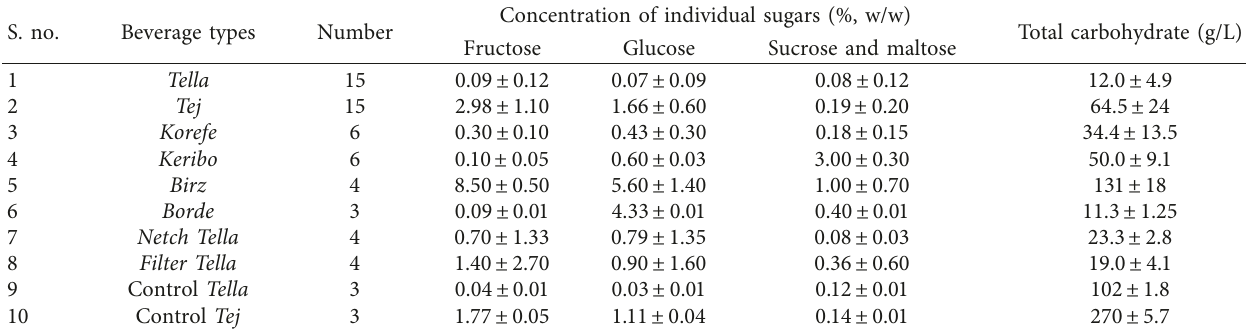
Table 6: The amount of sugars found in Ethiopian traditional fermented alcoholic beverages (individual sugars (%, w/w) by the HPLC-RI method and total sugar (g/L) by the sulfuric acid method). S.